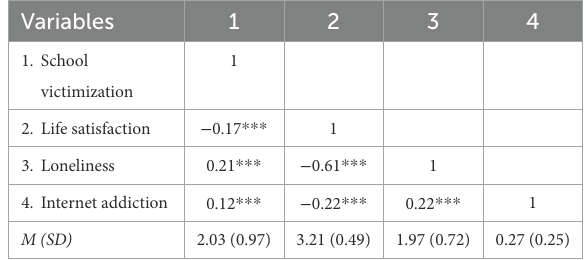
TABLE 1 Descriptive statistics and inter-correlations of the variables.